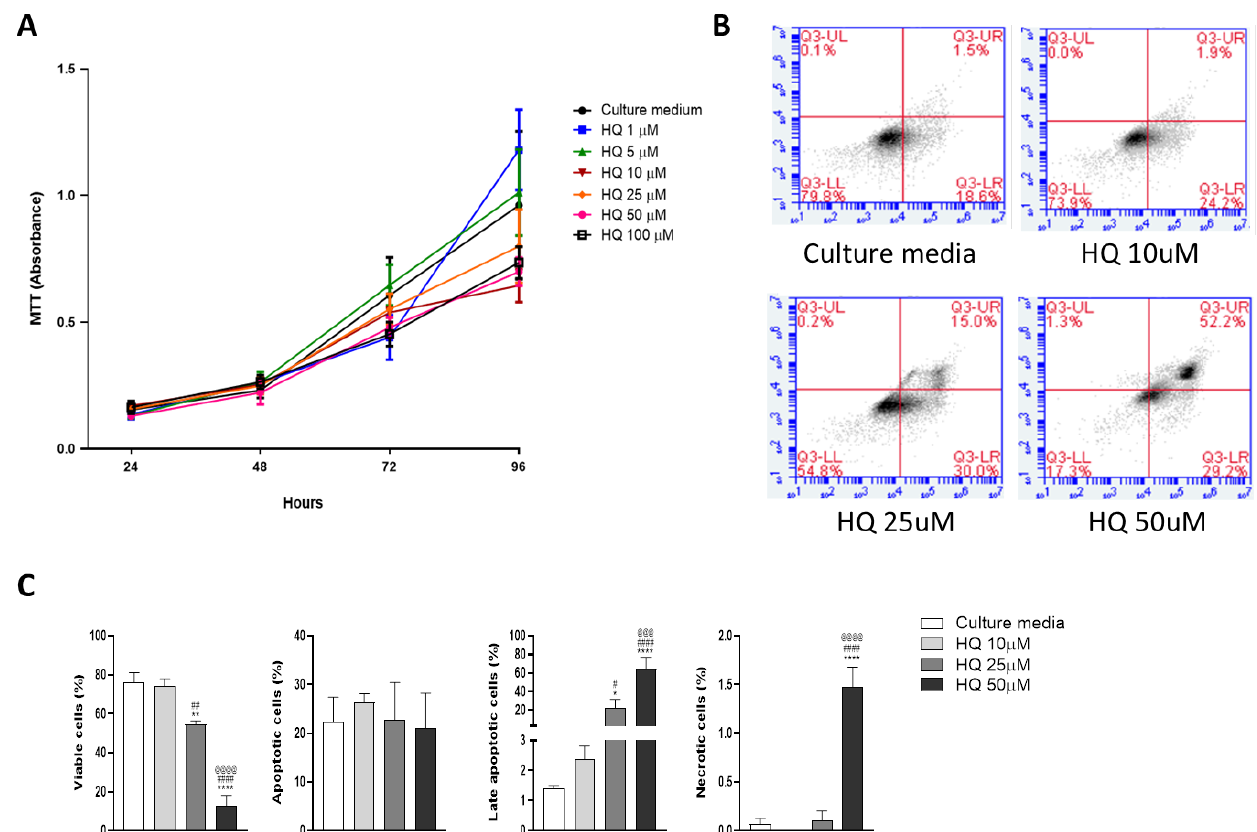
Figure 2. In vitro HQ exposure reduces viability and promotes apoptosis in a time and concentration- dependent manner. Stimulation of BACs with increasing concentrations of HQ (1–100 µ M) halted cell growth in a time-dependent fashion as evaluated by MTT assay ( A ). HQ treatment promoted cell death at the protein level upon exposure to a concentration of 50 µ M after 24 h of treatments ( B , C ), as quantified by the FACs method using Annexin V and 7-AAD dye. Data represented mean ± SEM from three independent experiments and were analysed by one-way ANOVA. ( A ): 24H: p = 0.0215 CM vs. 1 µ M; p = 0.0220 CM vs. 5 µ M; p = 0.0010 CM vs. 10 µ M; p = 0.014 CM vs. 25 µ M; p = 0.0001 CM vs. 50 and 100 µ M. 72H: p = 0.0049 CM vs. 25 µ M; p = 0.0001 CM vs.50 and 100 µ M. 96H: p = 0.0262 CM vs. 10 µ M; p = 0.0001 CM vs. 25, 50 and 100 µ M. ( C ): *, **, **** vs. Culture media; #,